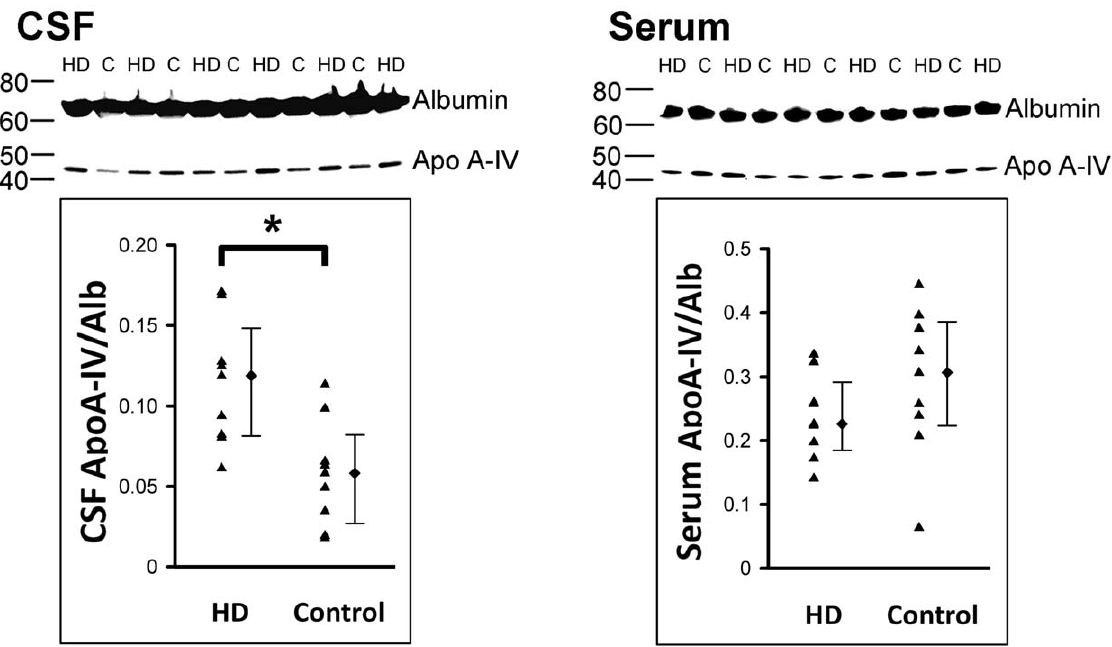
Figure 3. Representative Western blots of Apo A-IV (46 kD) and albumin (64 kD) in CSF and serum, respectively, of HD patients and their corresponding controls (C). The Apo A-IV/Alb ratios in CSF and serum in comparison with their corresponding control groups are illustrated in scatter plots with median and interquartile rang, respectively. The Apo A-IV/Alb ratio in CSF of HD patients (n=9) is significantly higher when compared with the controls (n=9). * p , 0.01, Mann-Whitney U test.